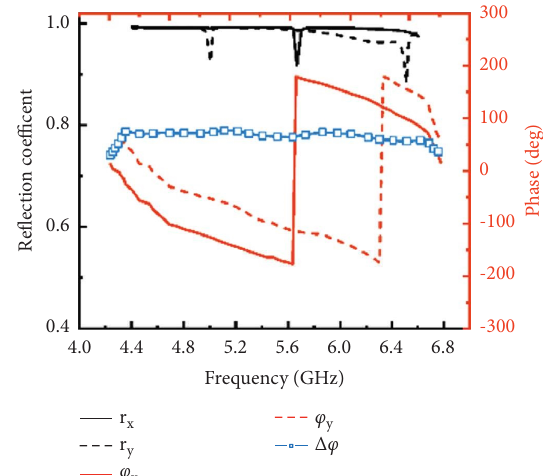
Figure 9: Simulated refection coefcients and phases of the unit cell.